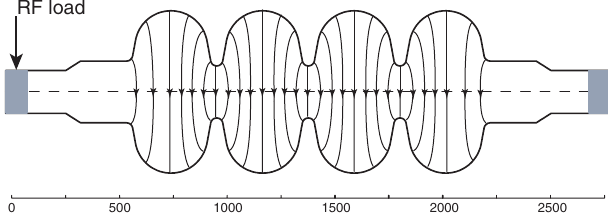
FIG. 1. (Color) A sketch of the LEP cavity. The rf electric field pattern is shown for the dipole mode at 446 MHz with vertical polarization (pillboxlike TE 111 , 0-type). In calculations, the loads of the beam pipes are matched to dipole modes propagat- ing into the beam